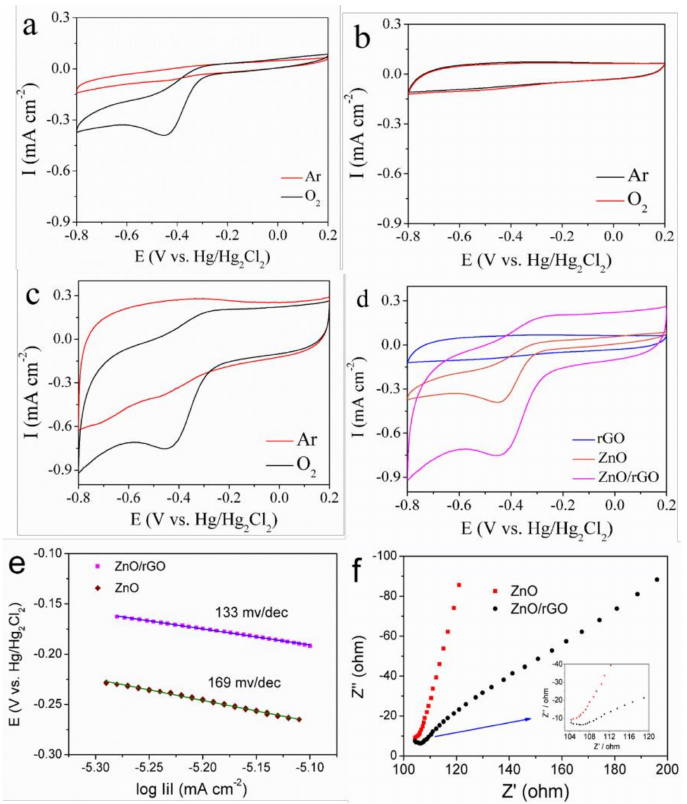
Figure 3. Cyclic voltammograms of ( a ) ZnO, ( b ) rGO and ( c ) ZnO/rGO in Ar and O 2 -saturated 0.1 M KOH at 25 ◦ C. ( d ) Comparation of CV tests on ZnO, rGO and ZnO/rGO. Scan rate 5 mV/s. Tafel plots ( e ) and EIS spectrum ( f ) of ZnO and ZnO/rGO.